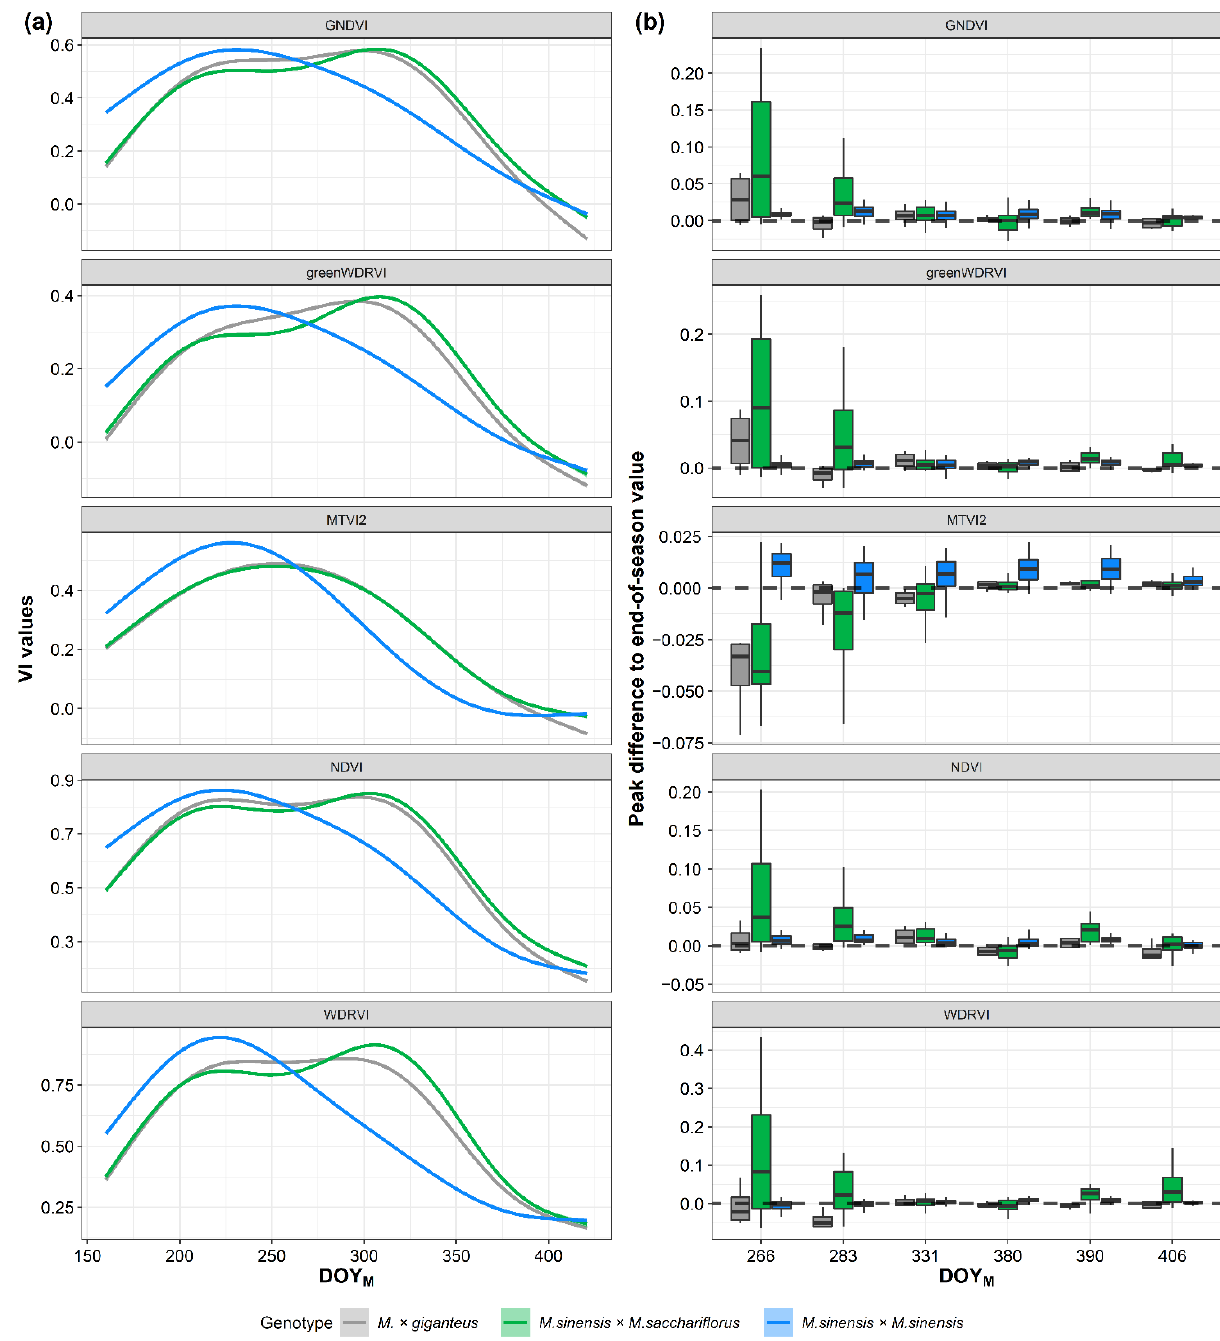
Figure 10. ( a ) Time series of the five VIs (GNDVI, greenWDRVI, MTVI2, NDVI, and WDRVI) fitted via the generalized additive model (GAM) throughout the growing season of Miscanthus in TWS 1. Modified days of the year (DOY M ) were calculated by adding 365 to the DOY of the corresponding year from January on. ( b ) Variation of the peak of the VIs derived from the complete time series of the VIs as compared to the peak of the VIs derived from the partial time series of the VIs. In the x-axis, the DOY M of the UAV flights performed during the season in TWS 1 are reported. In the y-axis, the peak differences between the peak derived to the end of the season in TWS 1 (421 DOY M ) and the peak derived from partial time series fitted until the DOY M of the UAV flight are reported.